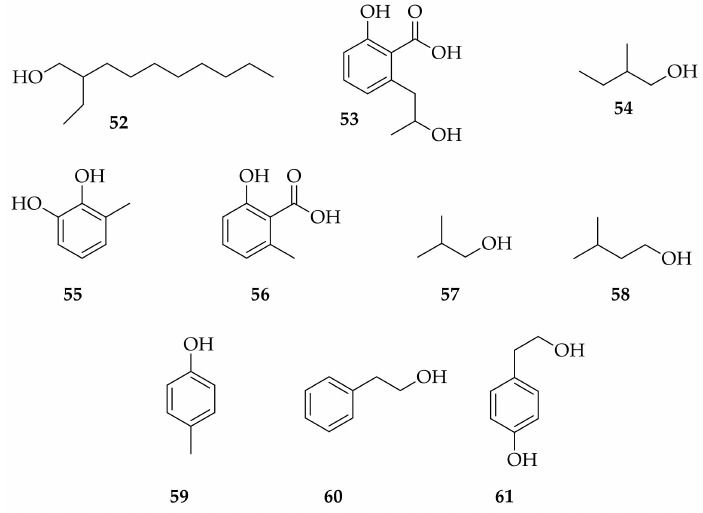
Figure 8. Structures of phenols and alcohols: 2-ethyldecan-1-ol, 2-hydroxypropyl salicylic acid, 2-methylbutan-1-ol, 3-methylcatechol, 6-methyl-salicylic acid, isobutanol, isopentyl alcohol, p-cresol, phenylethyl alcohol, tyrosol ( 52 – 61